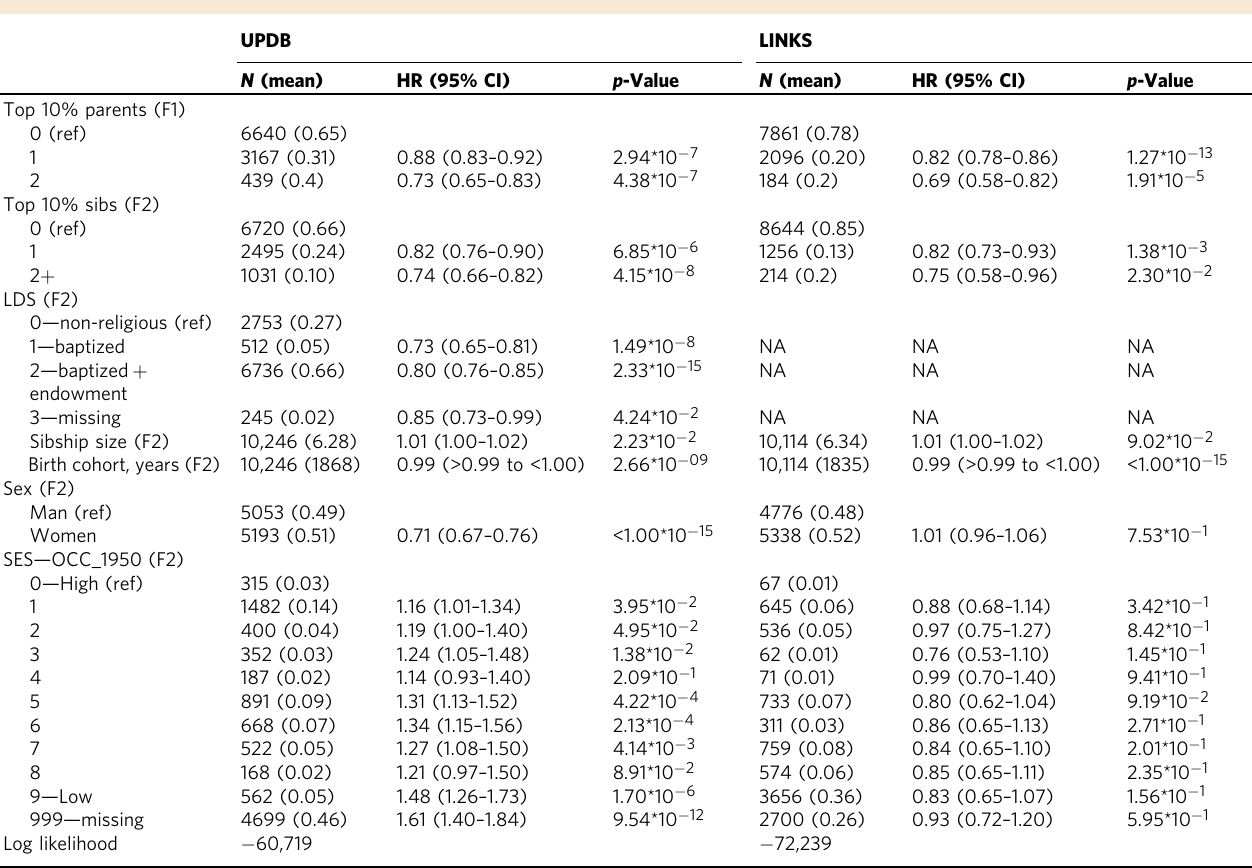
Table 2 Survival analysis for IPs with top 10% parents and siblings